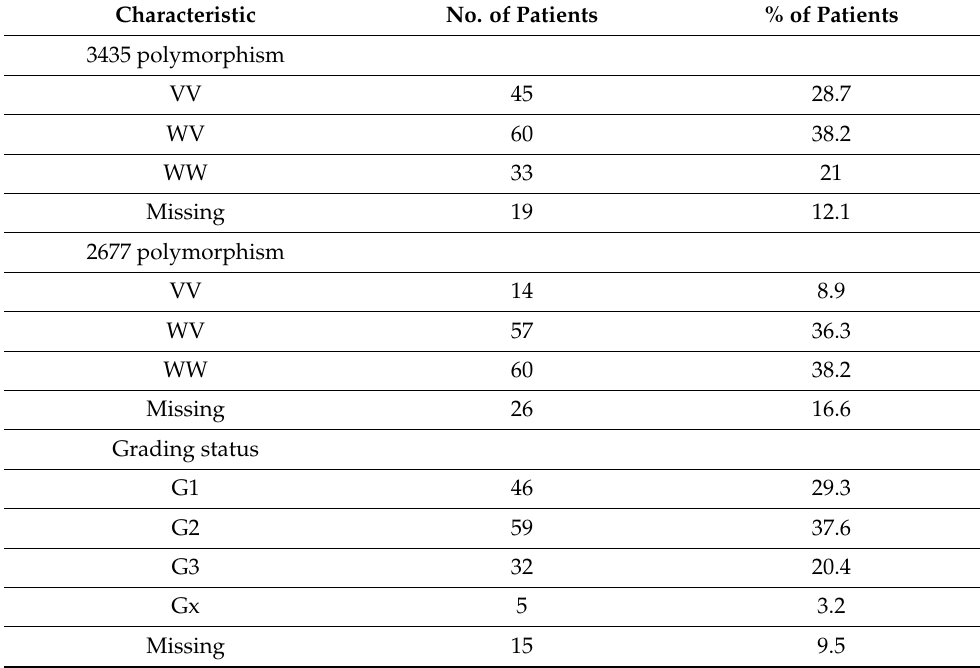
Table 1. Clinical characteristics of study participants. “Missing” stands for the patients who, relative to the study from 2012, were impossible to contact or the parameter was not found in the database.